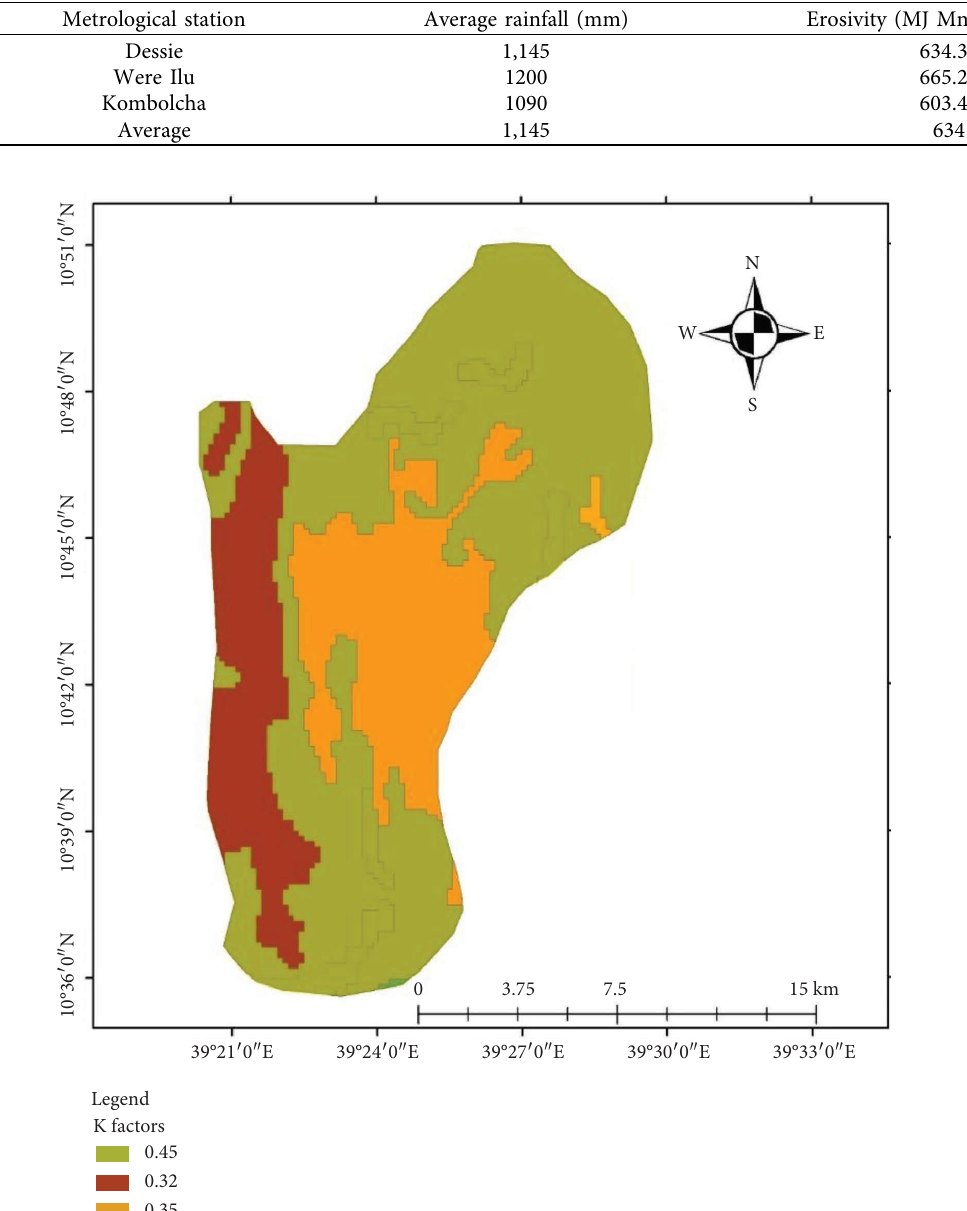
Figure 4: Erodibility ( K -factor) map of Kabe